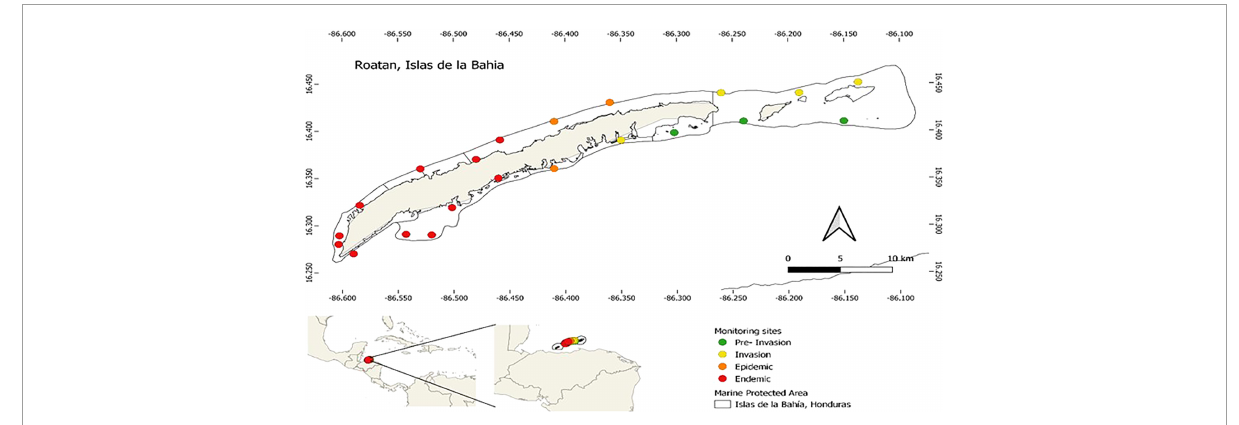
FIGURE 3 Outbreak condition of SCTLD as of September 2021 in the island of Roatan, in the Bay Island MPA, Honduras.